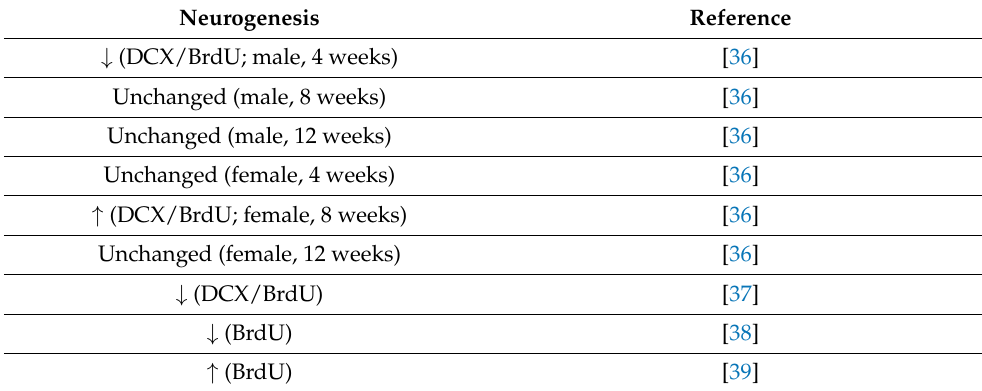
Table 1. Germ-free mice and